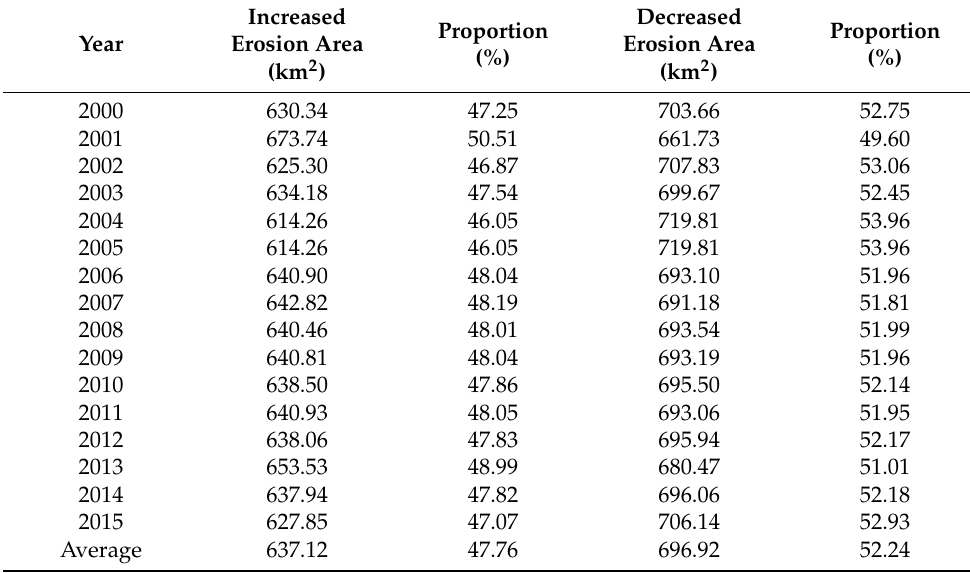
Figure 5. Spatial differentiation of the effect of vegetation restoration on soil erosion in 2000–2015. Table 6. Changes in soil erosion areas and proportions from 2000 to 2015.